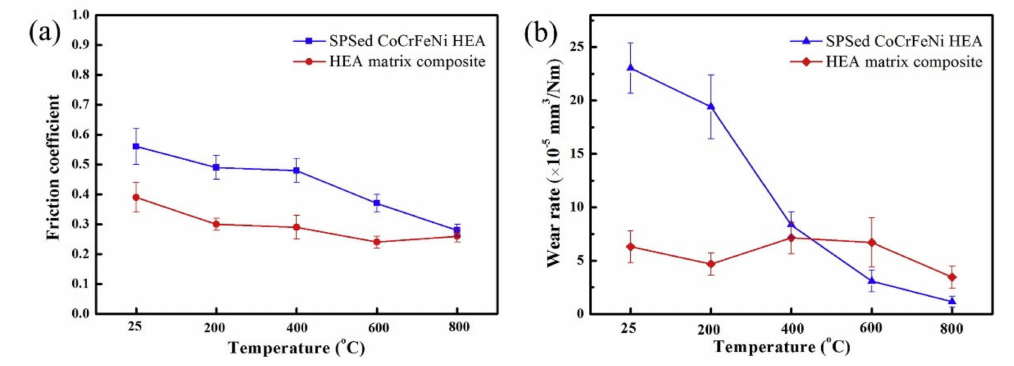
Figure 12. ( a ) COF and ( b ) wear rate for the CoCrFeNi HEA and its composite with MoS 2 and graphite